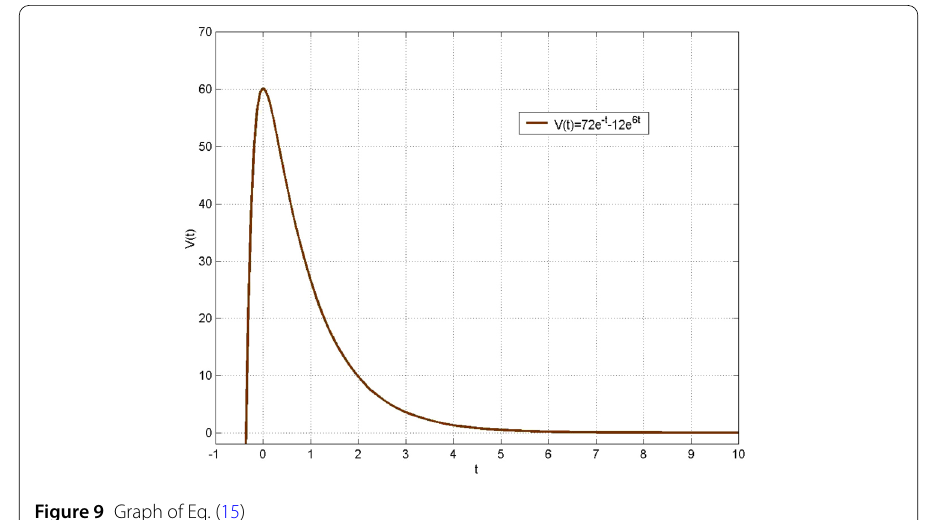
Figure 9 Graph of Eq. (15)